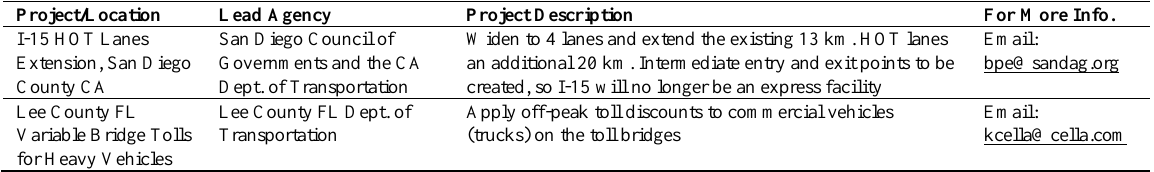
Table 2. Value Pricing Projects Likely to Be Implemented